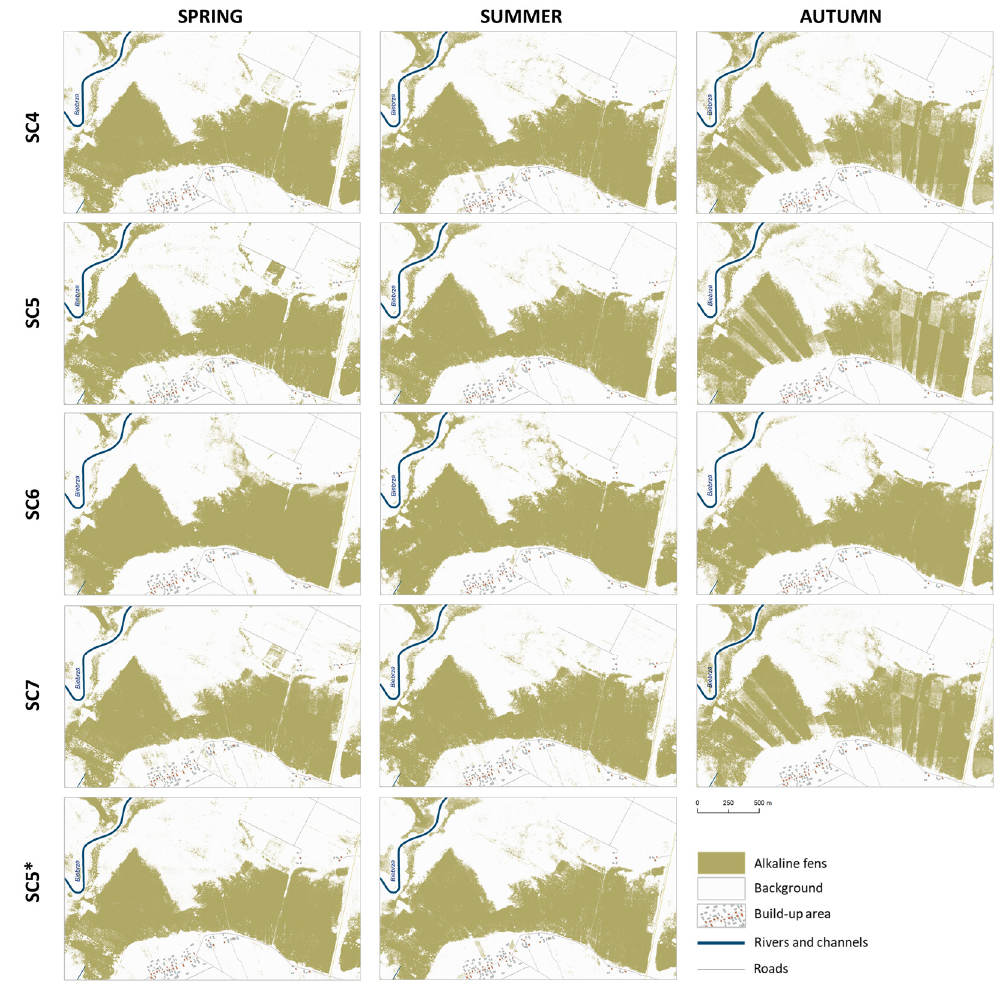
Figure 9. An example of comparison of classification results for alkaline fens in the UB area in spring, summer, and autumn campaigns for five scenarios in level 2 (SC4, SC5, SC5*, SC6, and SC7).